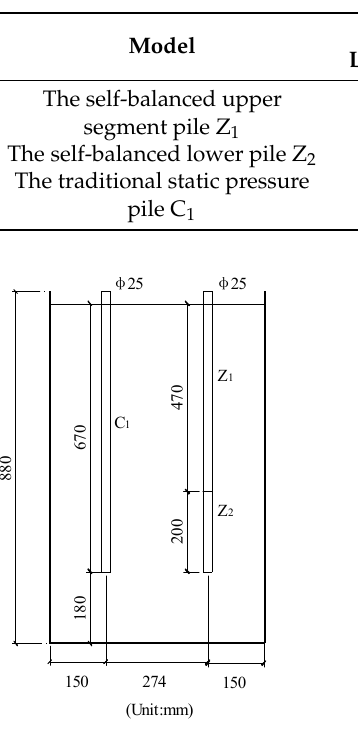
Table 1. Model test pile parameters.